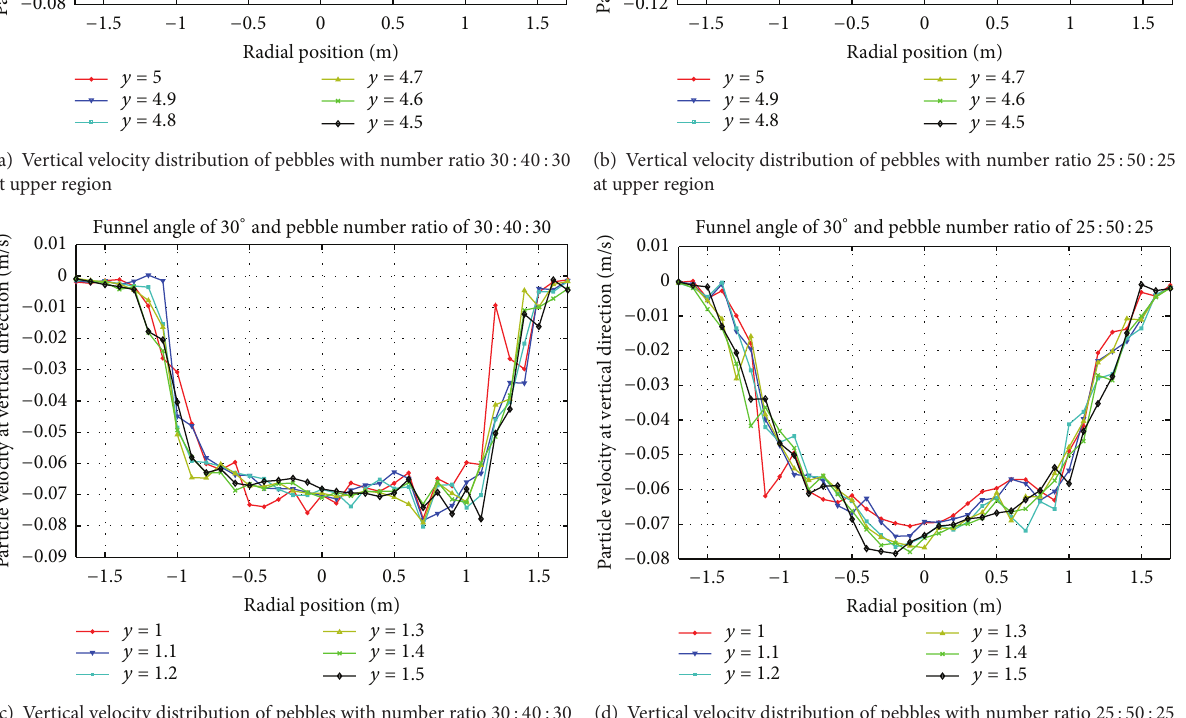
(d) Vertical velocity distribution of pebbles with number ratio 25:50:25 at lower region Funnel angle of 30 ∘ and pebble number ratio of 25 : 50 : 25